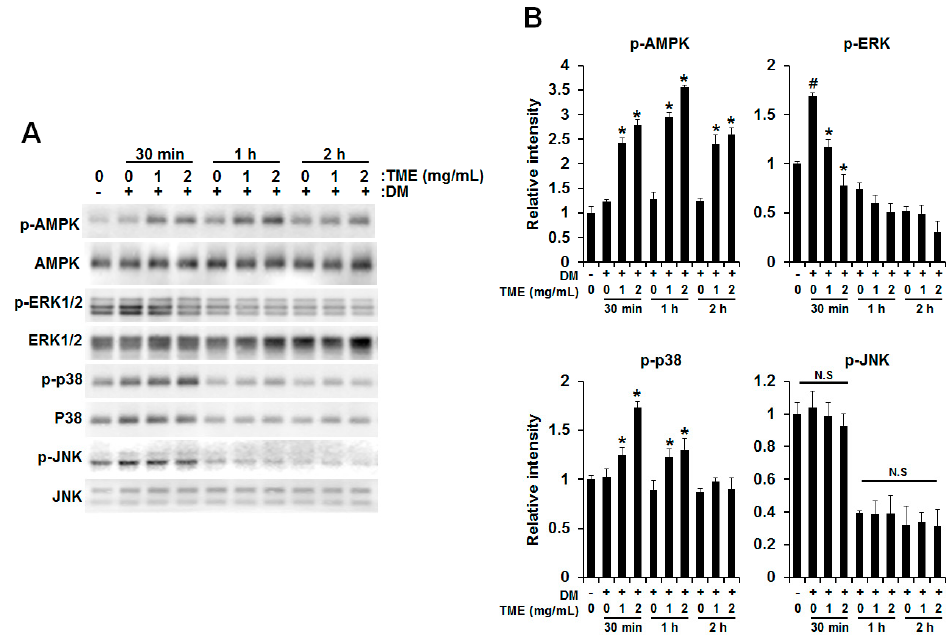
Figure 3. TME regulates phosphorylation of AMP-activated protein kinase (AMPK) and mitogen-activated protein kinases (MAPKs) during its inhibition of 3T3-L1 adipocyte differentiation. Cells were induced to differentiate into adipocytes in DM medium with or without TME for 30 min, 1 h, and 2 h; protein was extracted, and phosphorylation of AMPK, ERK, p38, and JNK was detected using western blot ( A ). Results of densitometric analysis of western blot are also shown ( B ). Experiment was performed three times using independently prepared cell lysates; representative blots are shown. # p -value of <0.05 indicates significant difference from non-differentiated control. * p -value of <0.05 indicates significant difference from differentiated control without TME. N.S: Not significant.